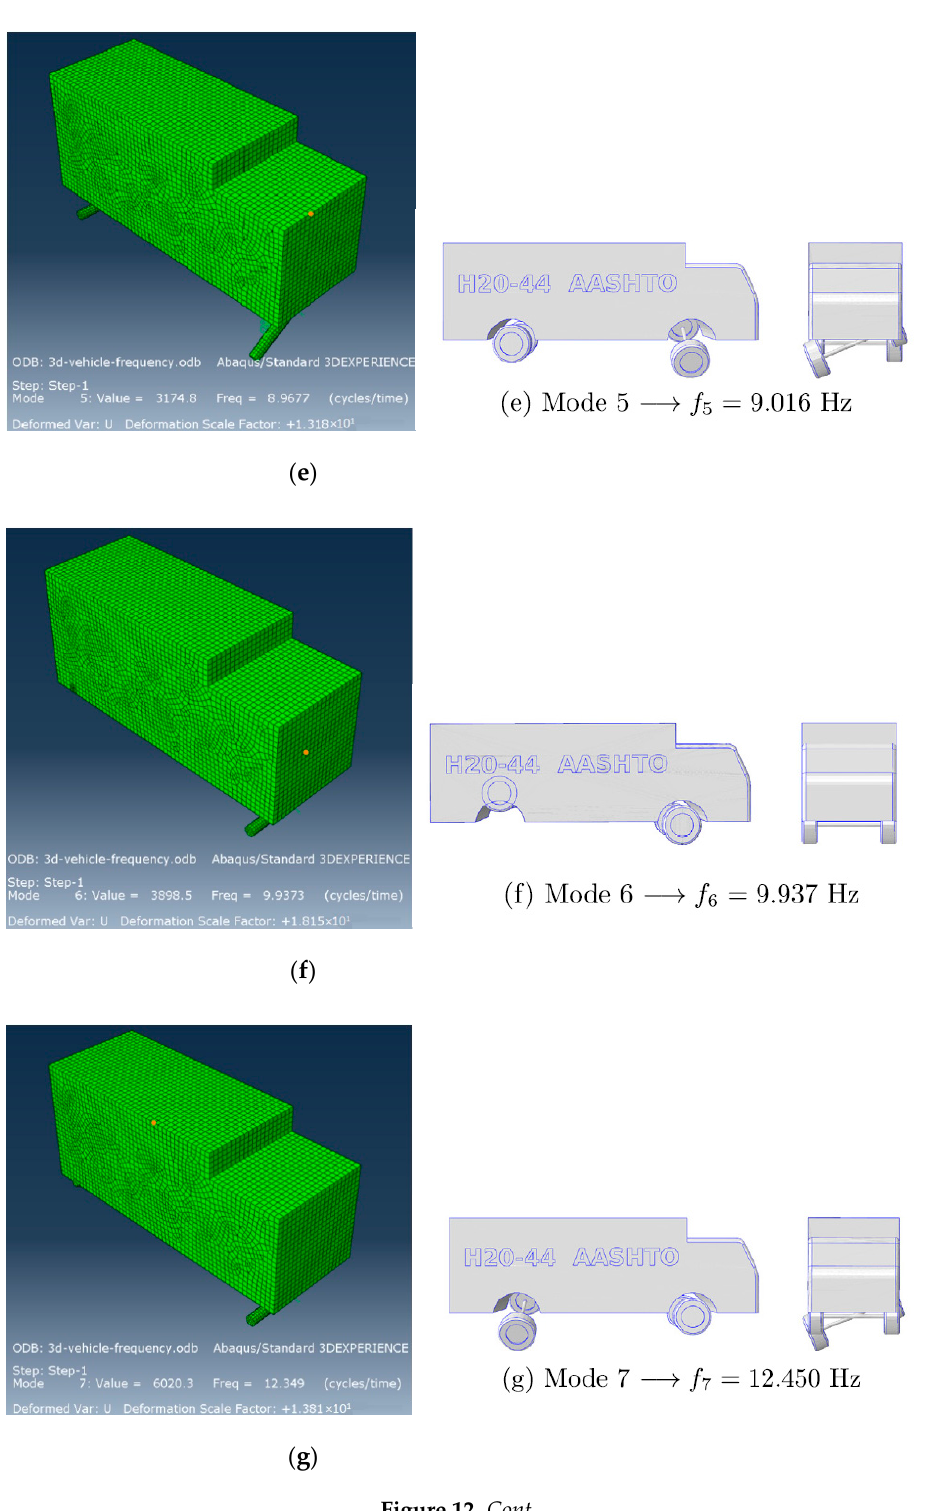
Figure 12. Cont Figure 12. Comparison of the model vehicle frequencies with the literature results. ( a ) Model 1, ( b ) Model 2, ( c ) Model 3, ( d ) Model 4, ( e ) Model 5, ( f ) Model 6, and ( g ) Model 7.